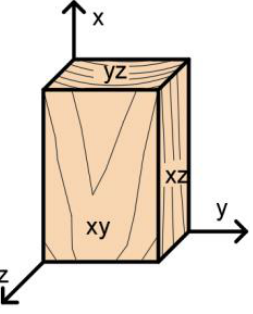
Figure 6. Orthotropy of timber.